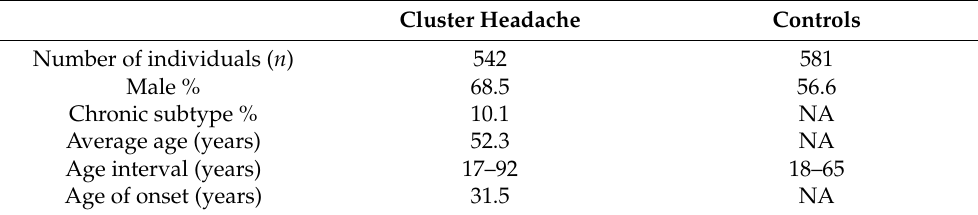
Table 1. The Swedish case-control material. Cluster Headache Controls Number of individuals ( n )